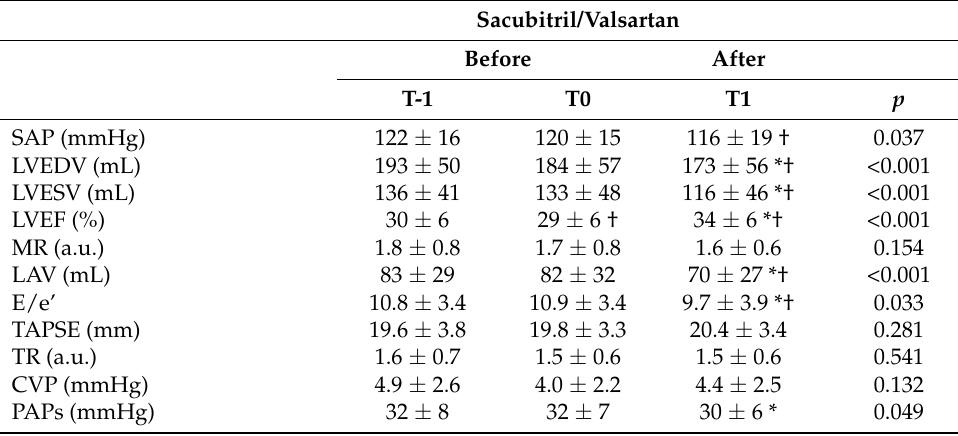
Table 2. Changes in studied parameters after sacubitril/valsartan